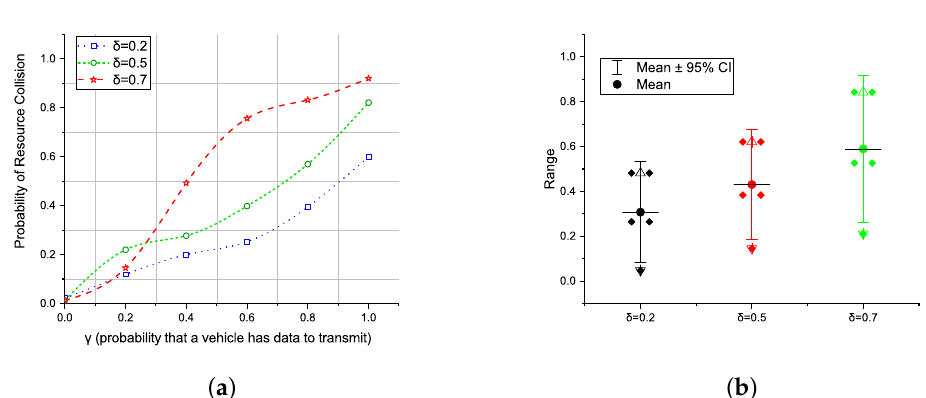
Figure 7. Resource collision probability; ( a ) of the Markov model and, ( b ) a confidence interval of 95%.